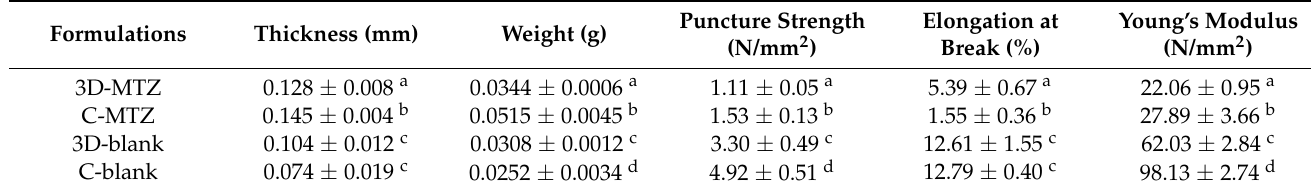
Table 2. Thickness, weight, and mechanical properties of